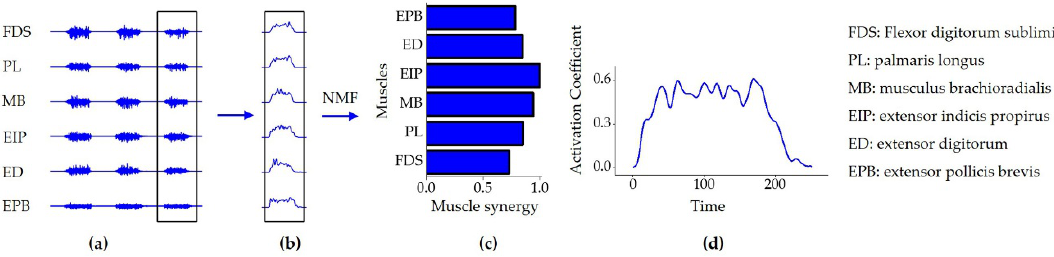
Figure 3. An example of the Non-Negative Matrix Factorization (NMF) decomposition to electromyography (EMG) signals. ( a ) The original surface electromyography (sEMG) signals acquired from six muscle channels of one participant when performing gesture F, ( b ) the extracted envelope EMG signal, ( c ) the muscle synergy when s = 1, and ( d ) the corresponding activation coefficient curve ( H ) when s = 1. The channel-muscle configurations were illustrated in Figure 1 as (1) FDS, (2) PL, (3) MB, (4) EIP, (5) ED, and (6) EPB.